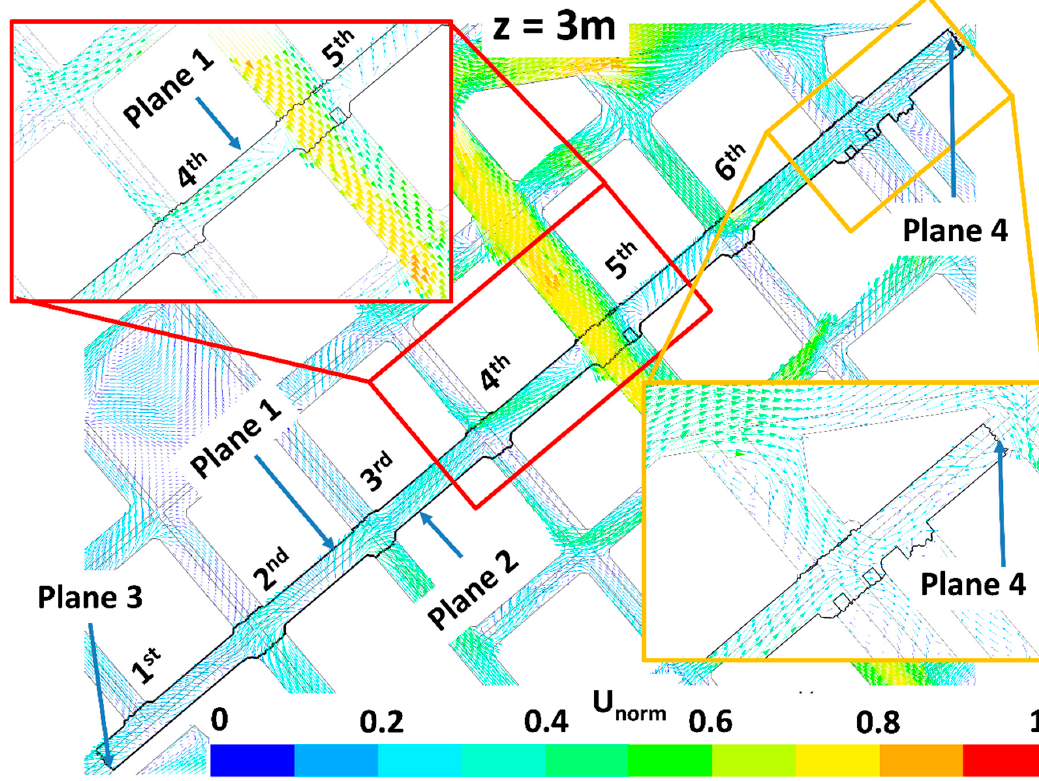
Figure 8. Same as Figure 6 but for the LAD01_NewTrees scenario.